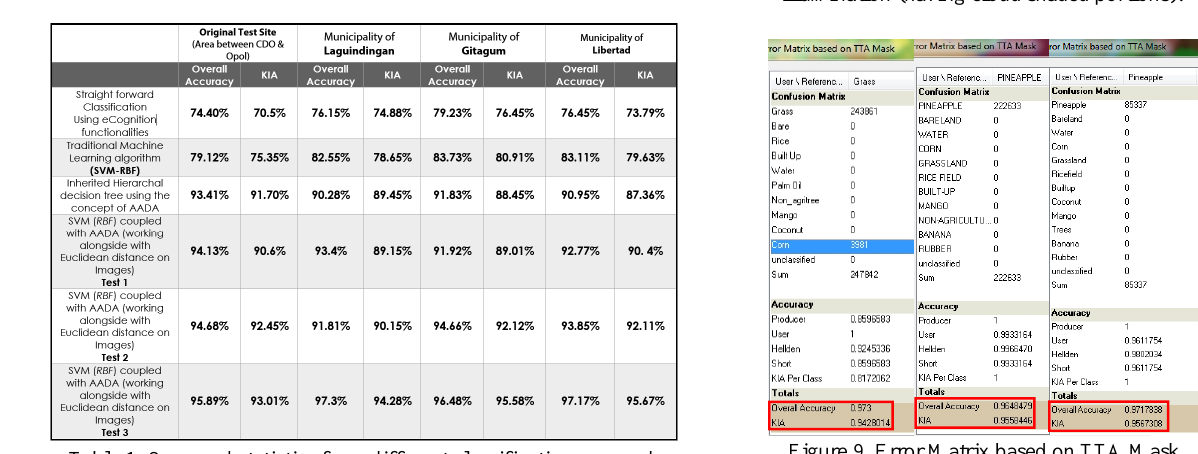
Figure 7. Classification result for the Original test site